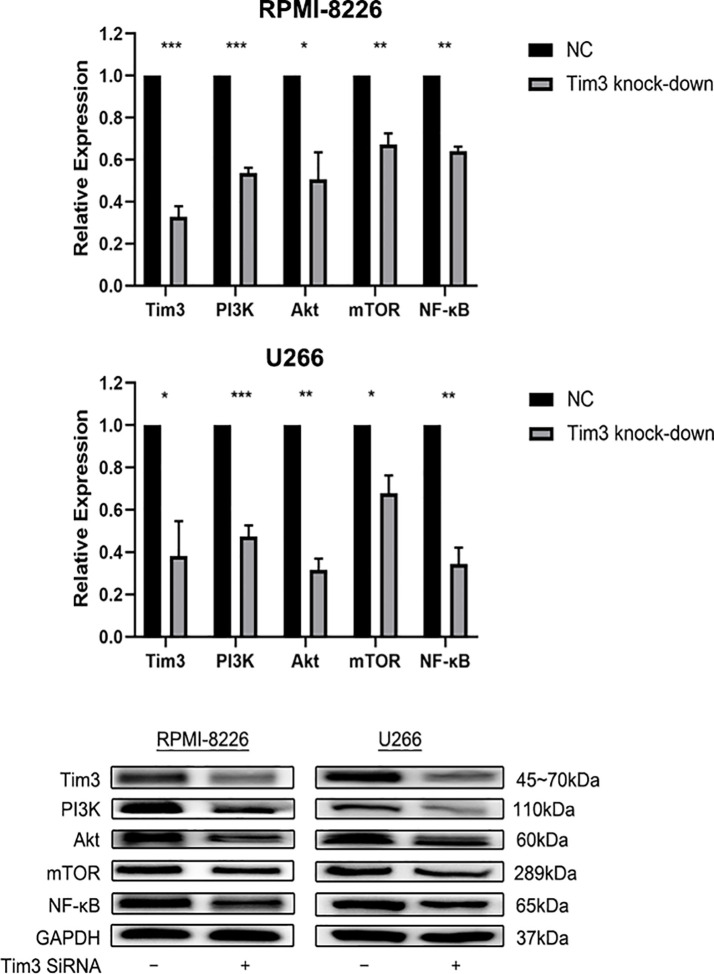
The effects of knocking down Tim3 on relative mRNA and protein expression of NF-κB signal pathway in RPMI-8226 and U266 cell lines. Shown are average values with standard deviations. Data are performed from 3 independent experiments.* indicated p<0,05, ** indicated p<0.01, *** indicated p<0.001.